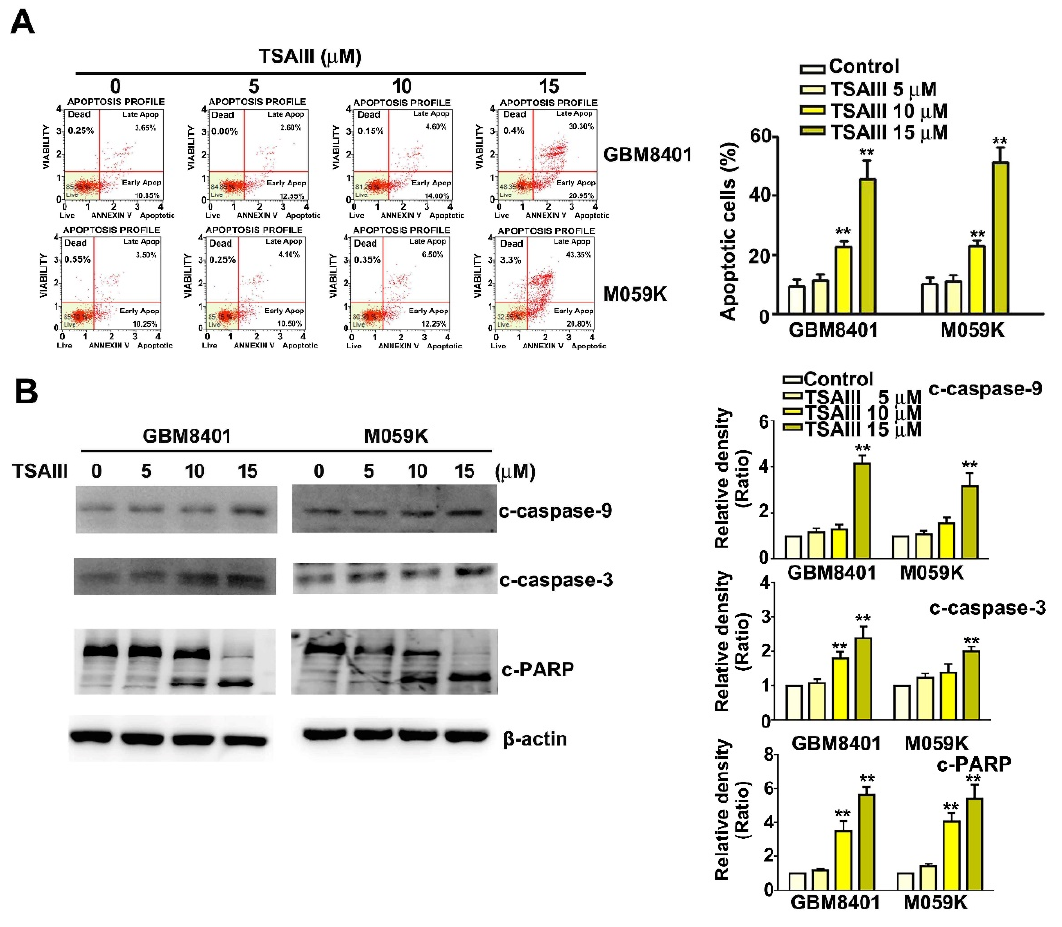
Figure 2. TSAIII induced cell apoptosis and caspase pathways in human glioma cells. ( A ) Human glioma cells (GBM8401 and M059K) were treated with various concentrations of TSAIII (0, 5, 10, 15 μ M) for 24 h, harvested, and assayed for apoptosis using Annexin V/ flow cytometry. ( B ) Western blot analysis of c-caspase-3, c-caspase-9, and c-PARP-protein expression in TSAII-treated cells. Quantification of band density was performed using ImageJ. Each experiment was repeated three times, and data are presented as the mean ± SE. ** p < 0.01 vs. untreated cells (control).